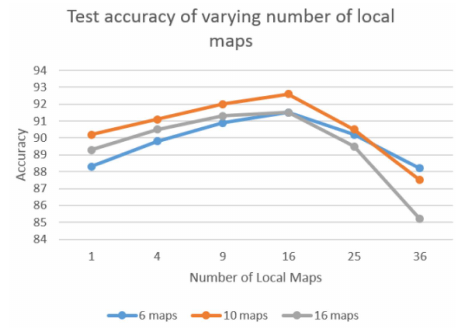
Figure 9. Test accuracy of varying number of local maps with fixed tile size